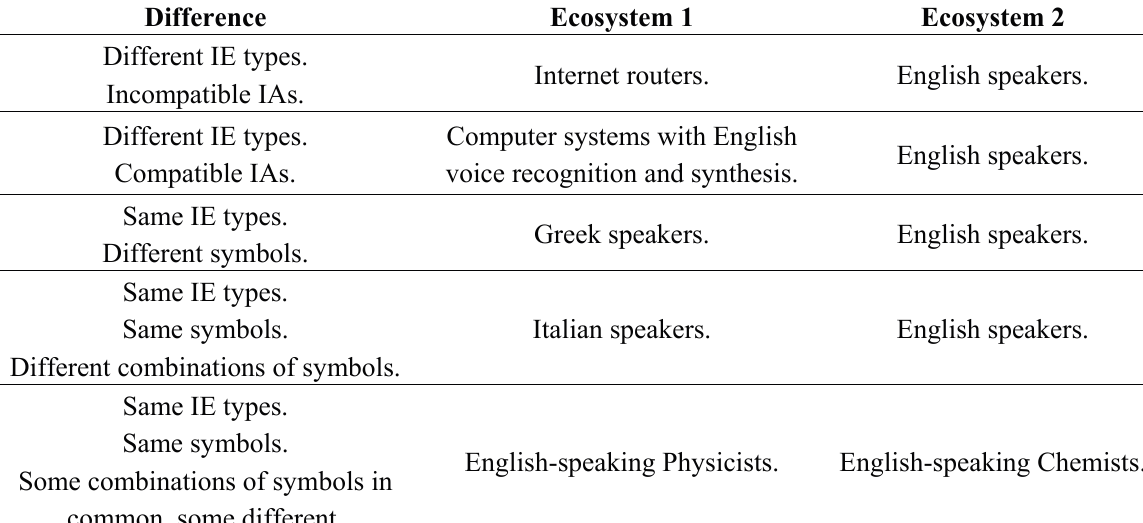
Table 1. The Proximity of